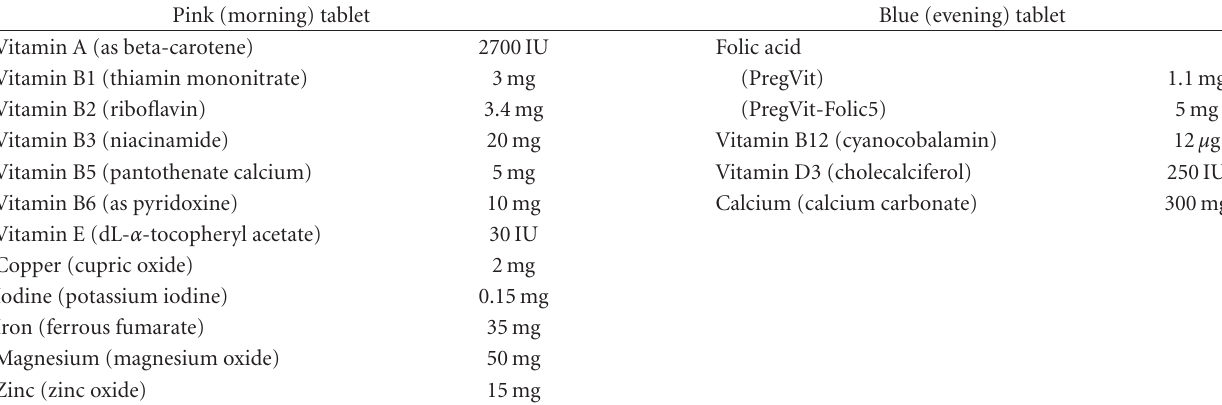
Table 1: Composition of study drugs, PregVit and